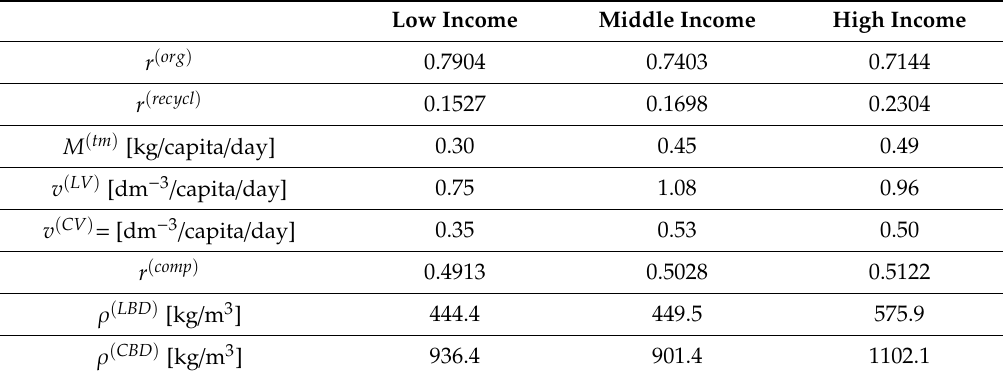
Table 8. Composition of study area household MSW by income